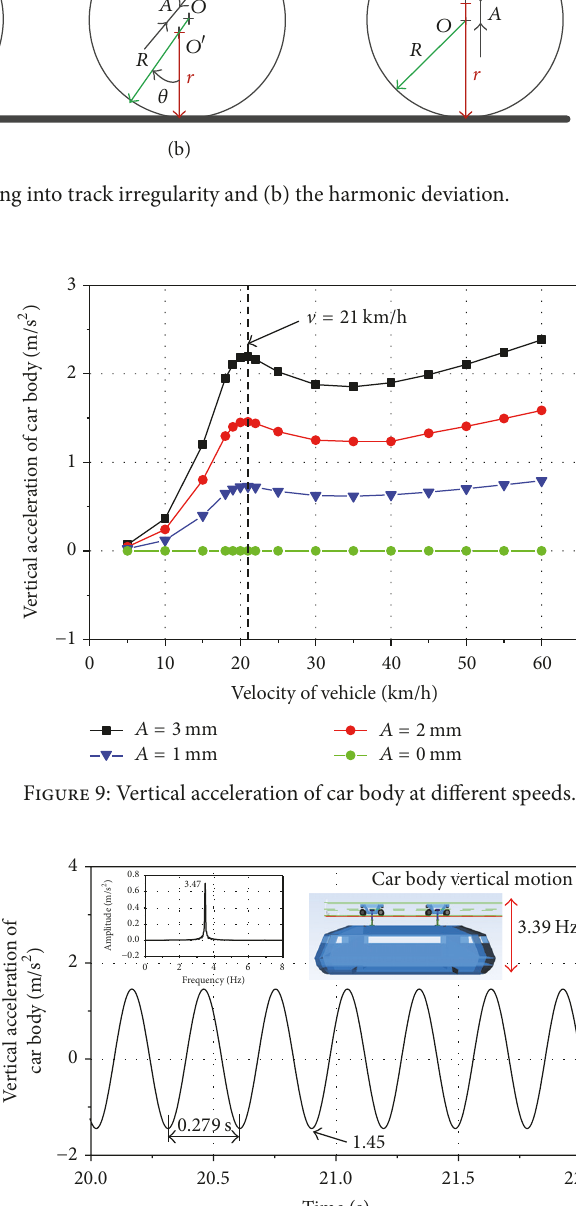
2 mm. For the case of wheel with eccentricity, the maximum vertical acceleration of car body is about 1.45 m/s 2 . The period of the oscillation of the acceleration is about 0.279 s. of wheel eccentricity for the car body acceleration at the speed of 21 km/h is 3.47 Hz approximately, which gets close to the resonant frequency of the car body vertical motion 3.39